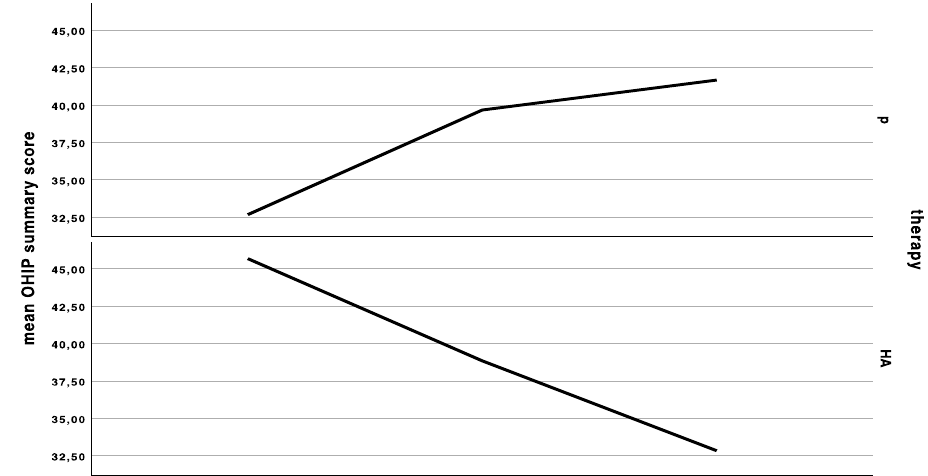
Figure 1. Curves indicating the mean clinical severity index (CSI), mean interleukin-6 (IL-6) levels in saliva, mean Oral Health Impact Profile (OHIP) summary score at the first baseline, cross-over, and last appointment in the group starting with placebo (p), and in the group starting with hyaluronic acid (HA), either for 6 weeks and a wash-out period of 48 h in between treatments.